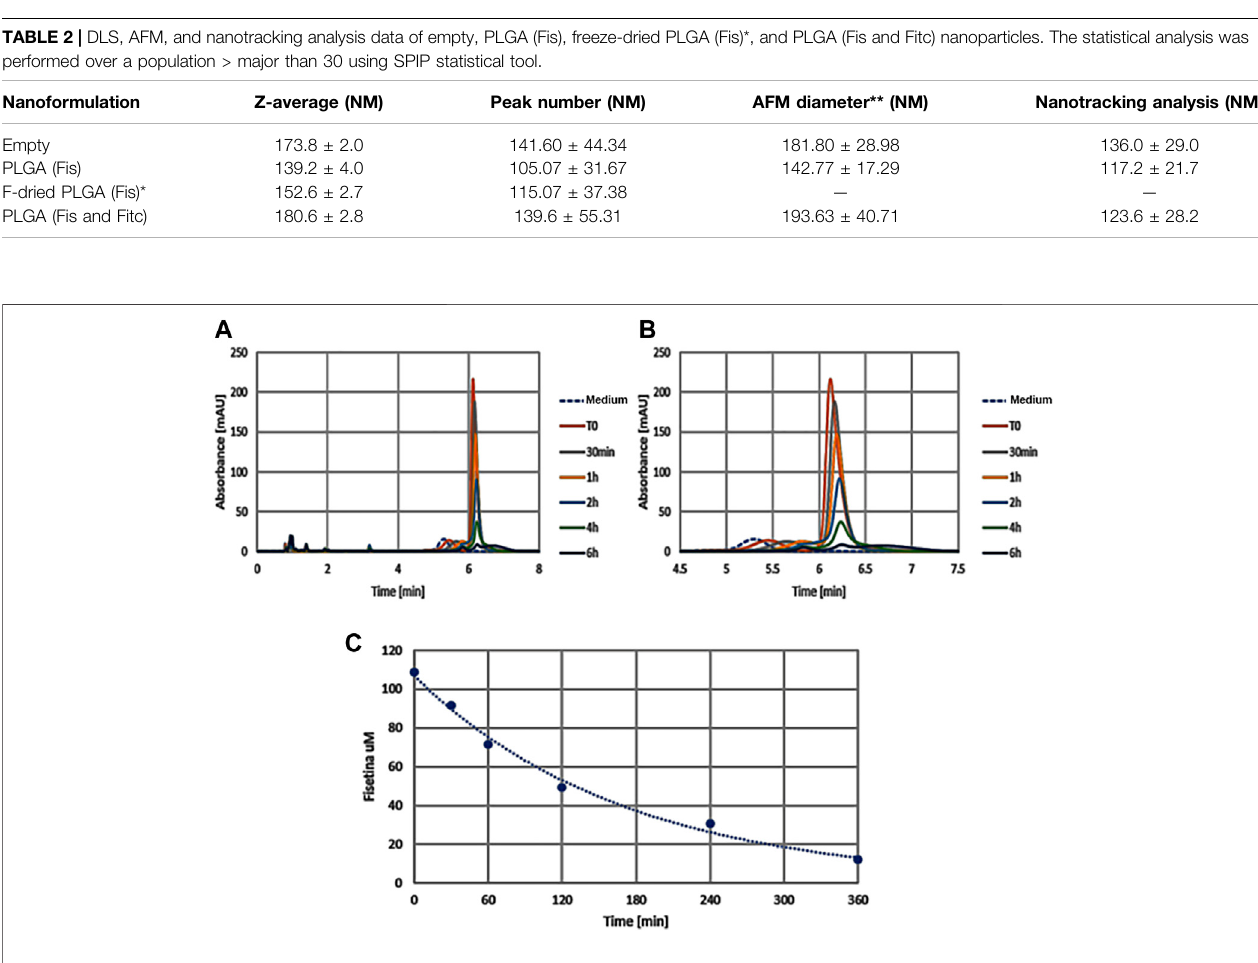
data are shown in Table 3 : after 5-h incubation, less than 5% of the initial concentration crossed the epithelium, while a value of 30% was reached within 16 h.